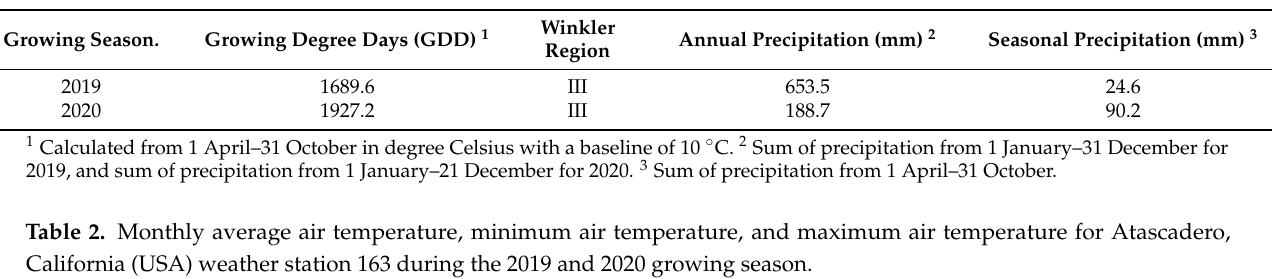
Table 1. Growing degree days (GDD); Winkler region classification; and precipitation for Atascadero, California (USA) weather station 163.